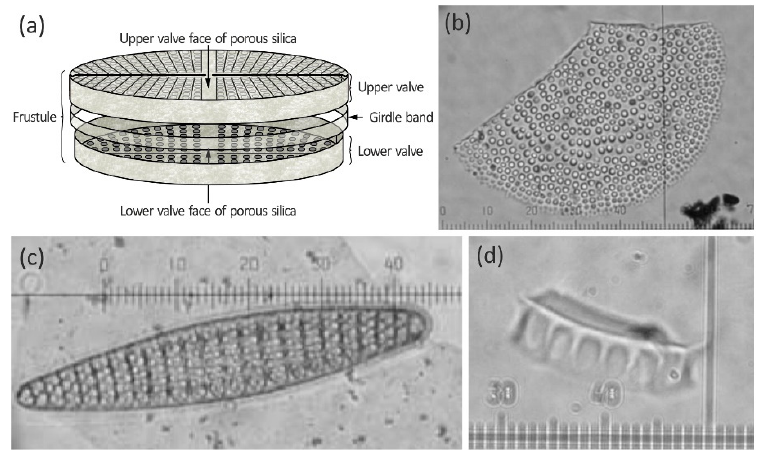
Figure 3. ( a ) Illustration of a diatom frustule; b, c and d: images of diatoms from the Ferrigno ice core: ( b ) broken valve of Thalassiosira lentiginosa; ( c ) whole valve of Fragilariopsis kerguelensis ; ( d ) fragment of a Dactyliosolen girdleband. Scale bars are in microns.